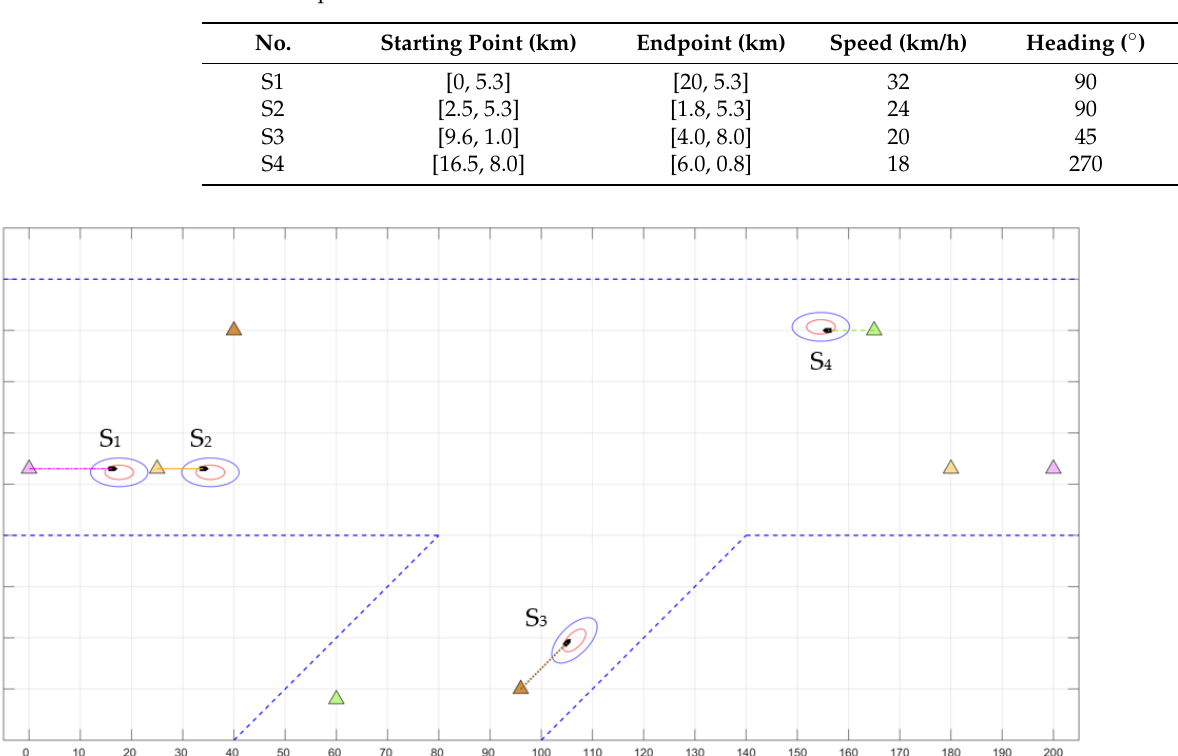
Table 6. Ship initial information.